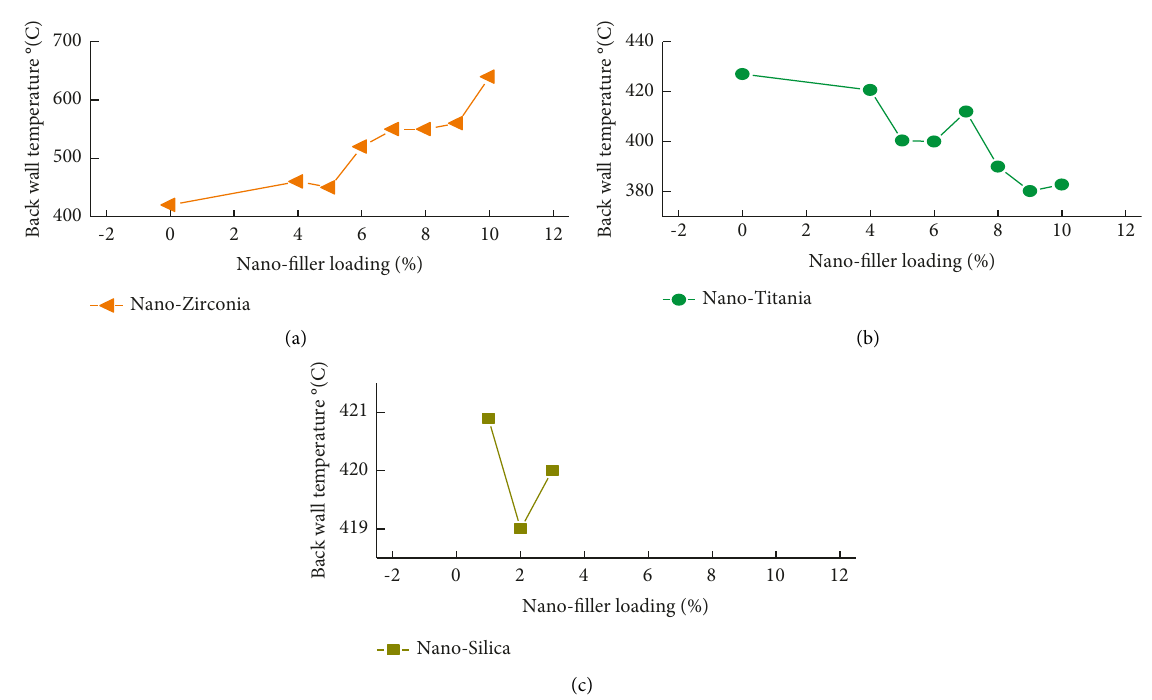
Figure 11: Back wall temperature as a function of filler loading for the nanocomposite panel.